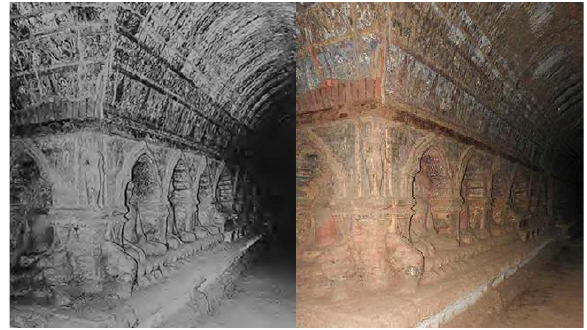
Figure 4. Photographic comparison of the same corridor